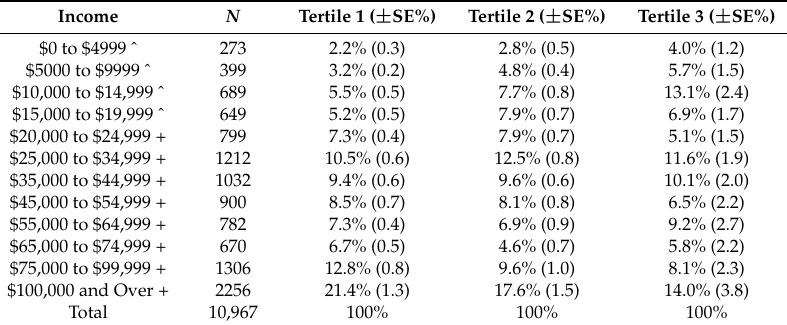
Table 5. Income and Tertiles of